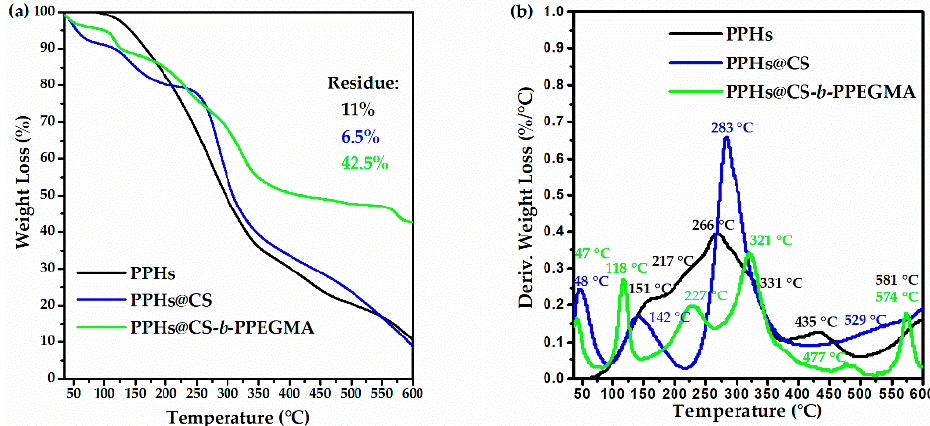
Figure 9. Thermal stability of loaded and unloaded PPHs: ( a ) TG-thermogram and ( b ) DTG- thermogram of Polyphenolics Compounds (PPHs), PPHs loaded in CS (CS@PPHs), and PPHs loaded in CS- b -PPEGMA (CS- b -PPEGMA@PPHs).